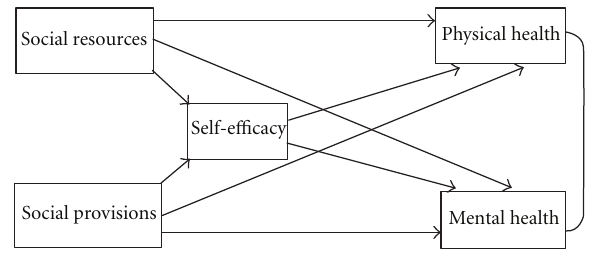
Figure 1: The study’s conceptual model was based on the theoretical work of Antonucci et al.